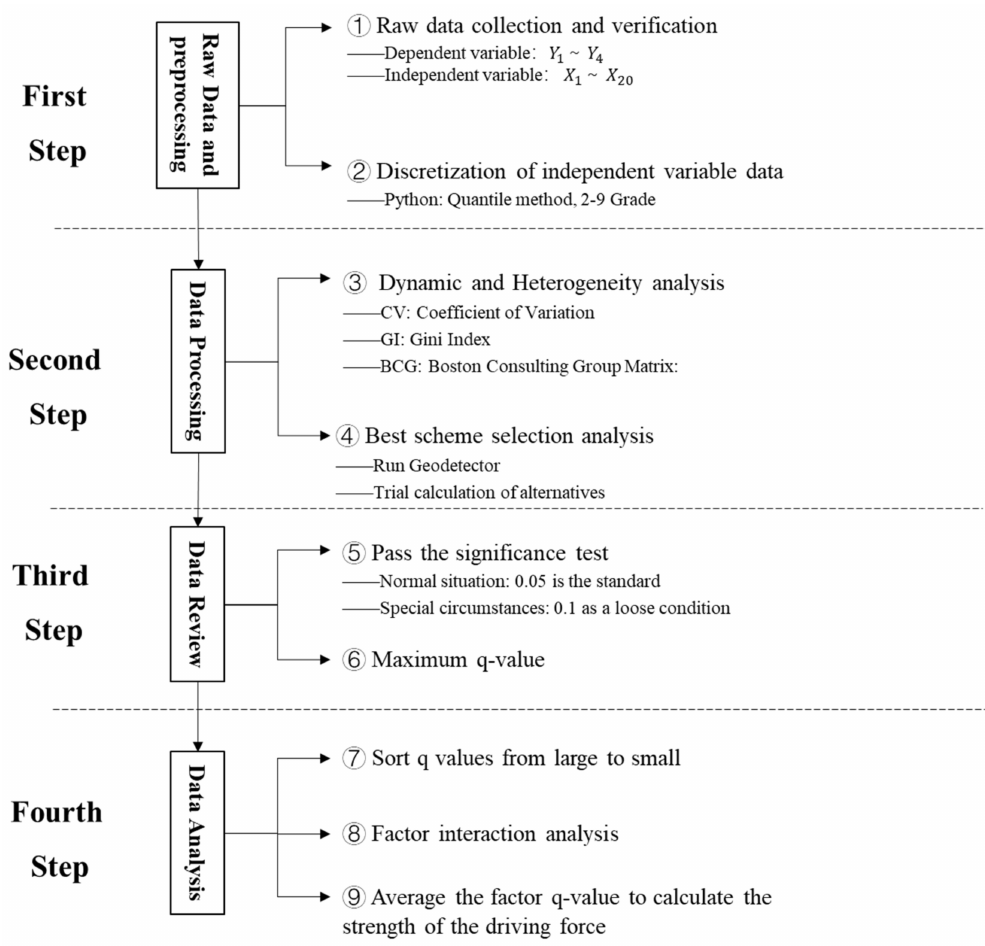
Figure 2. Research framework and